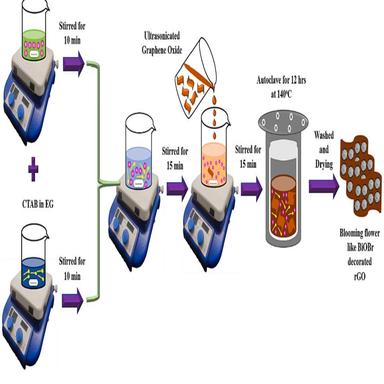
Schematic synthesis of BiOBr/RGO nanocomposite by solvothermal method.